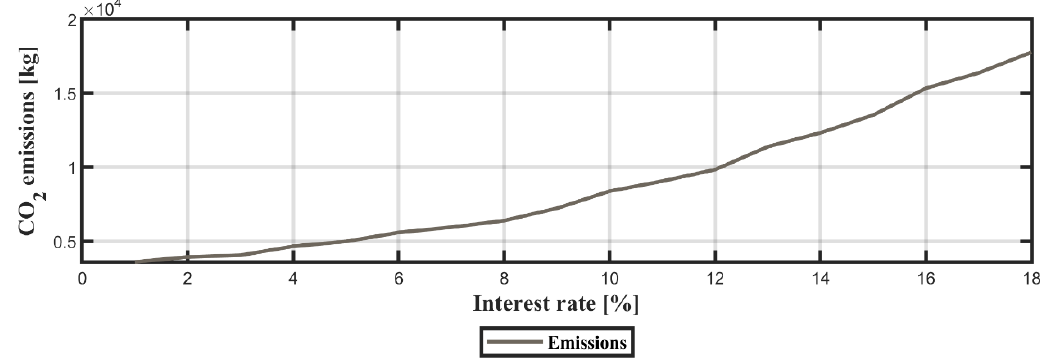
Figure 23. Simulation results of interest rate variation. Impact on CO 2 emissions.